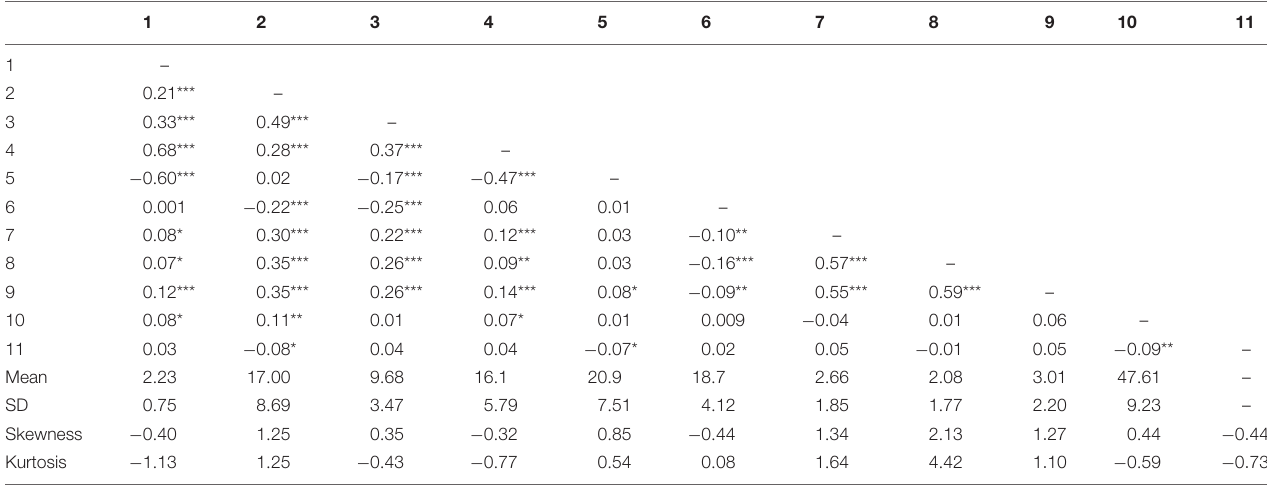
TABLE 1 | Descriptive statistics and correlations between study variables.